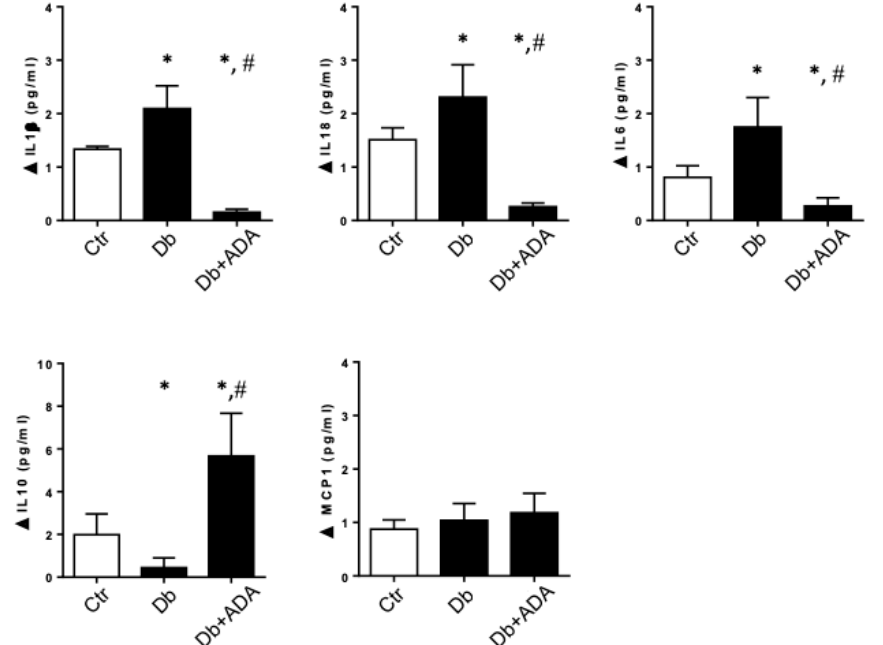
Figure 1. The administration of adenosine deaminase in diabetic rats affects the levels of cytokines. The pegylated-adenosine deaminase (ADA) or vehicle were administered to diabetic rats for a four weeks period. The levels of the cytokines IL-1 β , IL-18, IL-6, IL-10, and MCP-1 were quantified in urines of rats by using Immunoassays & MILLIPLEX ® map system. The control group (Ctr) corresponded to non-diabetic rats ( n = 6), the diabetic group (Db) corresponded to streptozotocin (STZ)-induced diabetic rats treated with vehicle ( n = 5) and the diabetic treated group (Db + ADA) corresponded to STZ-induced diabetic rats that received ADA at doses 5U / Kg per week ( n = 6). *, p < 0.05 vs. control; # , p < 0.05 vs. Diabetic.